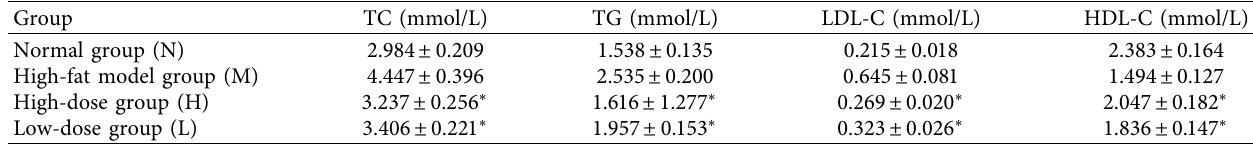
Figure 7: Variation trend of body weight of KM mice with time. Table 4: Determination results of components in serum of KM mice in each group.